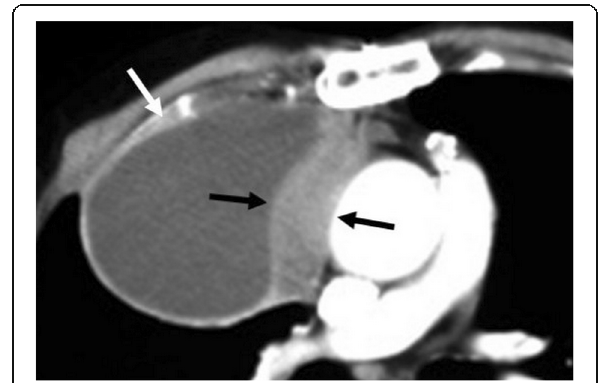
Fig. 14 A 45-year-old man with pathologically proven pericardial mesothelioma. Axial contrast-enhanced CT image shows a heterogeneous pericardial mass with solid (black arrows) and cystic (white arrow) components. Note that there is a lack of fat tissue between the ascending aorta and the mass raising suspicion for perivascular